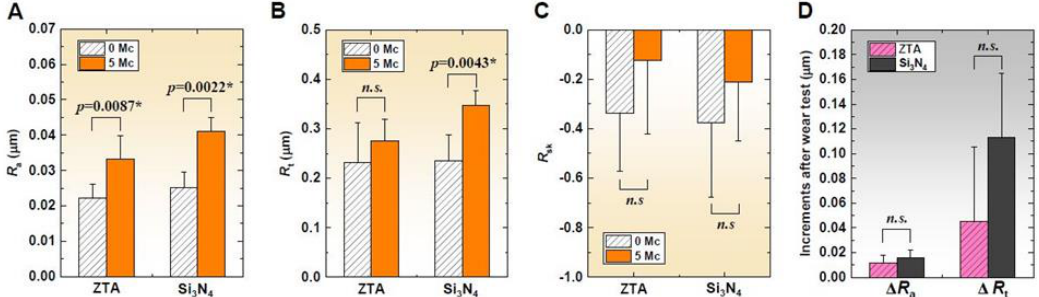
Figure 4. Comparison of surface roughness of ZTA and Si 3 N 4 materials before and after wear; ( A ) R a ; ( B ) R t ; and ( C ) R sk . In ( D ), compared increments in R a and R t after wear. The asterisks and n.s. represent p < 0.05 and p > 0.05, respectively.